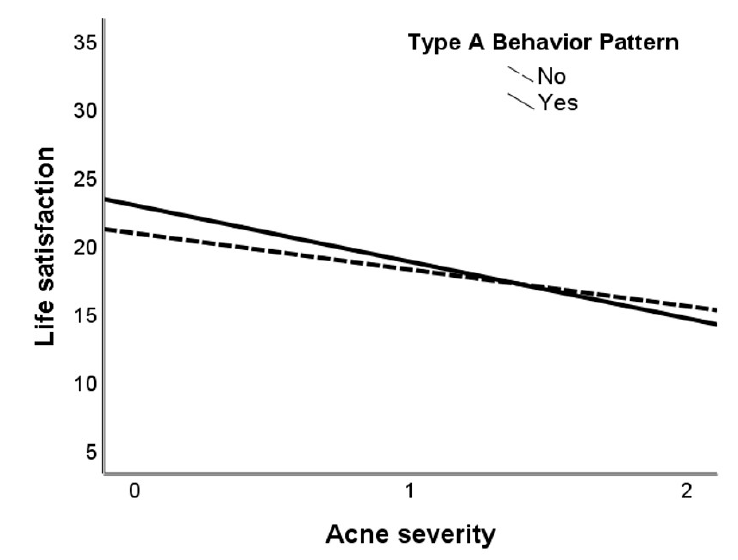
ff ect between acne severity and TABP on satisfaction with Figure 1. An interaction effect between acne severity and TABP on satisfaction with life. Figure 1. An interaction e